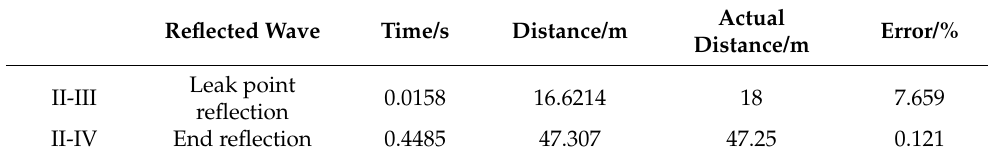
Table 3. Calculation of the reflected wave.